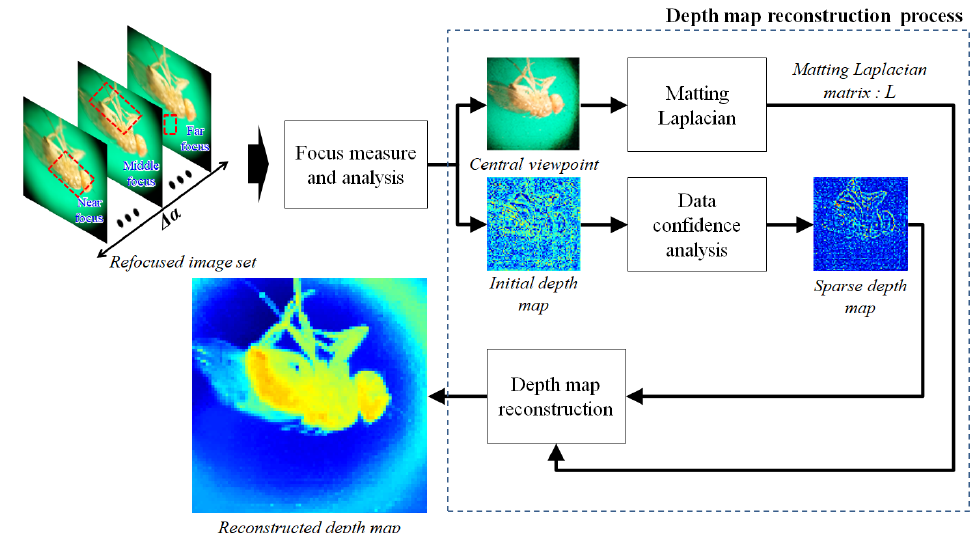
Figure 4. Depth estimation